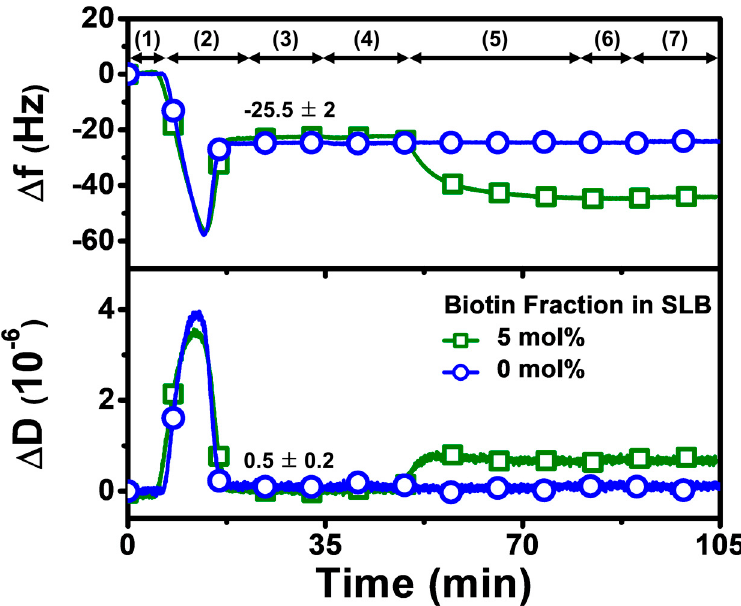
Figure 2. QCM-D tracking of biotinylated SLB fabrication on silica-coated sensor chip surface. Time- resolved QCM-D frequency ( ∆ f) and energy dissipation ( ∆ D) signals for SLB formation. The initial baseline stage denoted as (1) corresponds to pH 7.5 buffer solution, followed by (2) the addition of lipid bicelles that contain 0 or 5 mol% biotinylated lipid and (3) washing with pH 7.5 buffer. After SLB fabrication, a (4) buffer exchange step was performed to switch to the appropriate test pH, and then (5) 1 µ M protein (neutravidin or streptavidin) was added in the test pH condition, and (6) buffer washing with the test pH was performed, before finally (7) rinsing with pH 7.5 buffer in the pH 6.3 and pH 8.7 cases. At stage (3), the listed values correspond to ∆ f and ∆ D shift values for biotinylated SLB fabrication and are reported as mean ± standard deviation from all experiments in the study. The control experiment with the SLB containing 0 mol% biotinylated lipid verified that biotin-binding protein was specific to biotinylated SLBs, and stable adsorption did not occur due to nonspecific interactions